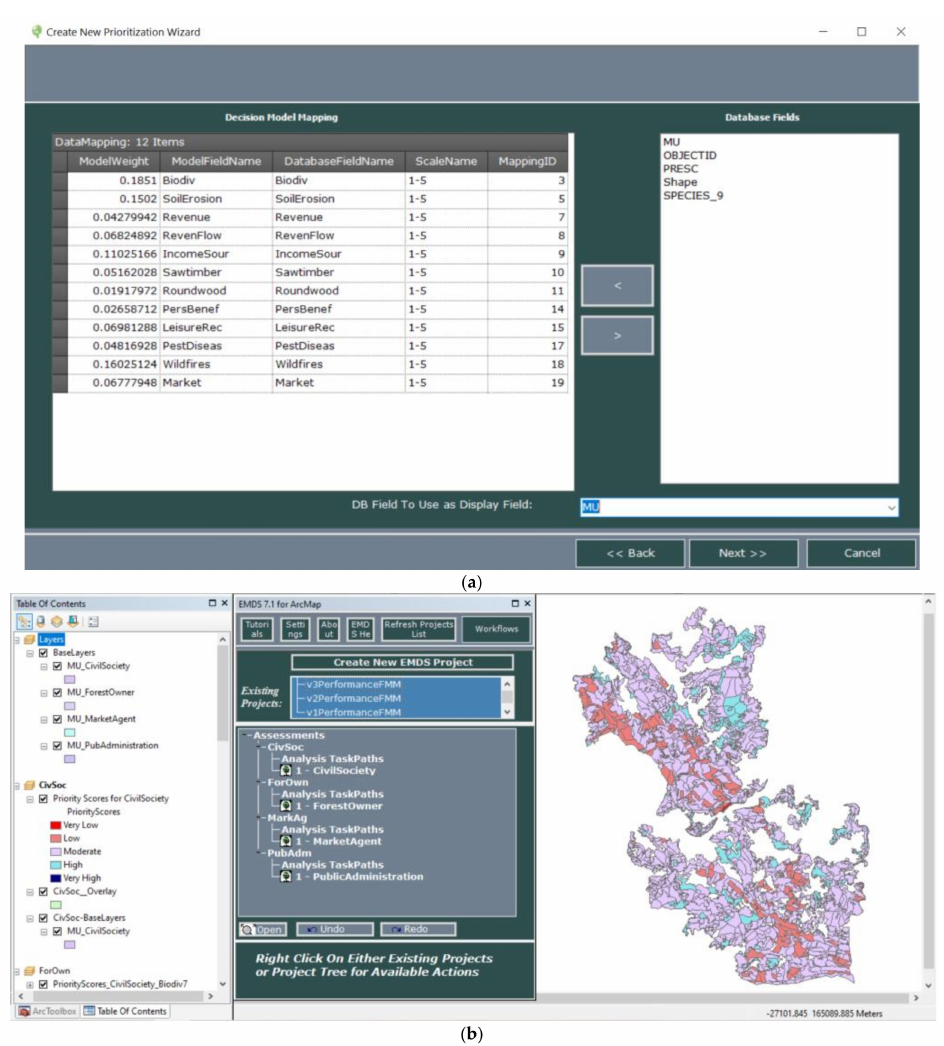
Figure 5. Example of the EMDS assessment of an interest group: ( a ) map the management units database fields (column “DatabaseFieldName”) to the CDP decision model (column “ModelDeci- sionName”); ( b ) results of priority scores. Per Section 2.2.1, these priority scores have immediate application to ESs